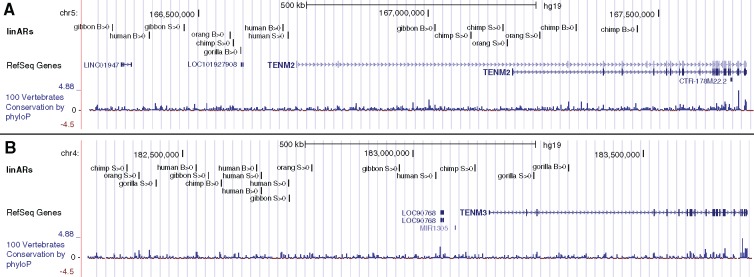
Clusters of linARs nearby teneurin transmembrane genes. Browser views of loci containing two of the largest multispecies linAR clusters nearby the genes (A) TENM2 and (B) TENM3. Genes and conservation are shown with UCSC Genome Browser tracks. A custom track shows linARs annotated by species and unbiased acceleration (S > 0) or GC-biased acceleration (B > 0).